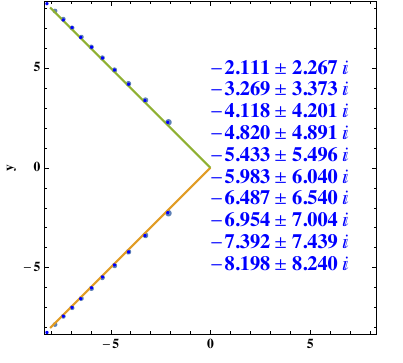
(cid:16) (cid:17) z p with the largest real part. (cid:0) 1 2 2